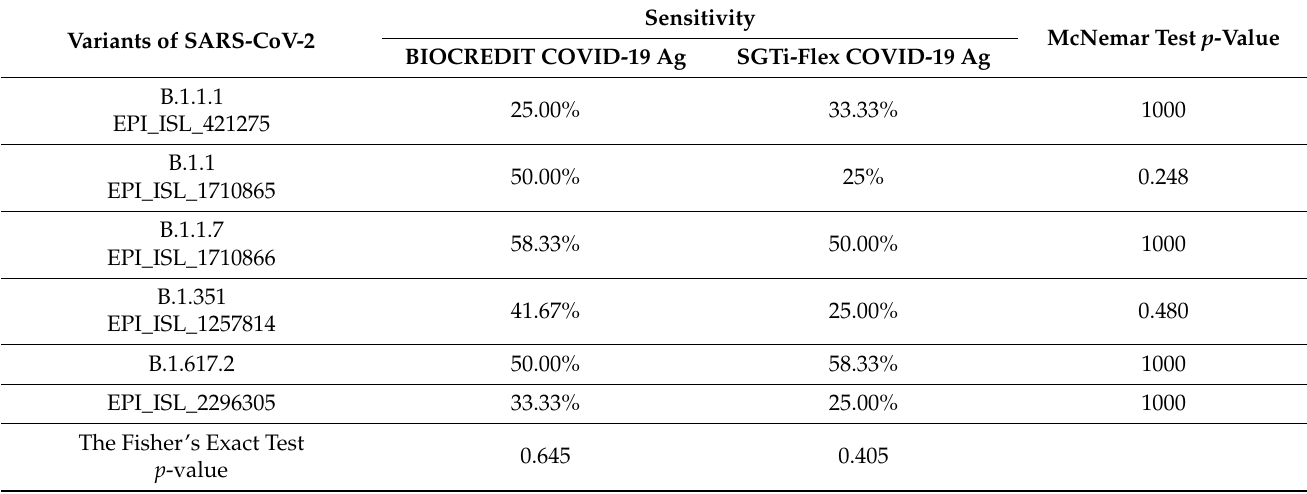
Table 1. Assessment of sensitivity of rapid tests compared to RT-PCR with Alpha, Beta, and Delta variants of SARS-CoV-2. Variants of